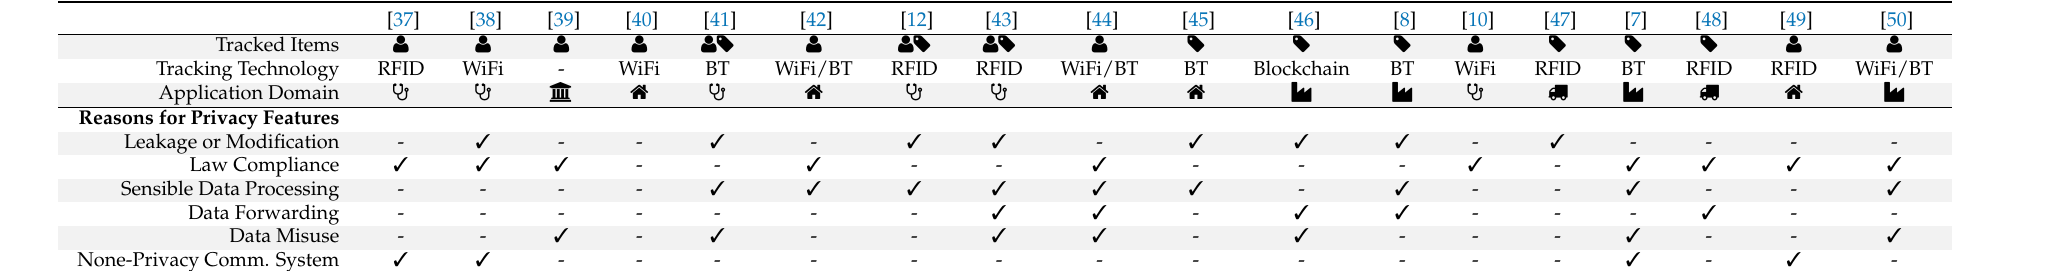
Table 4. Reasons why privacy features or the PbD concept were implemented ( # : = Objects, g : = Persons, (cid:26) : = Healthcare, (cid:19) : = University, (cid:153) : = Smart Home, ¯ : = Industry, 4 : =